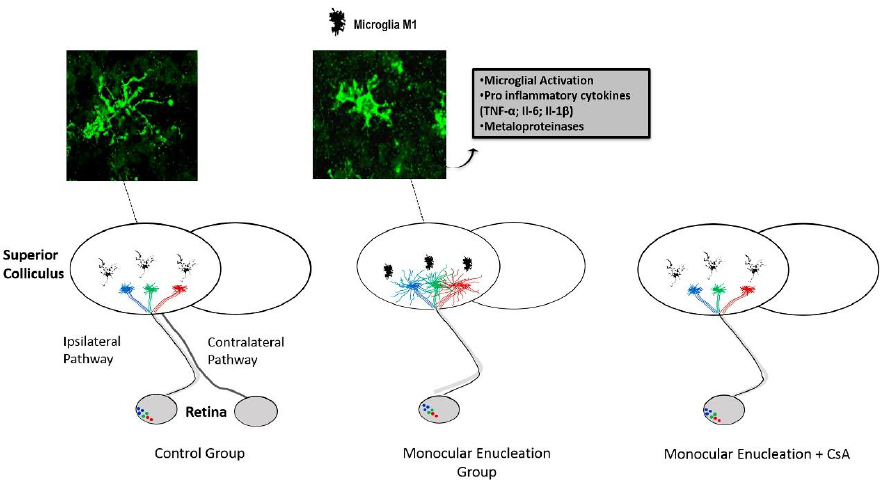
Figure 1. The rodent visual system reveals the effect of microglial activation on the modulation of the regenerative capacity of axons from the intact eye axons following a neonatal lesion (monocular enucleation) during early postnatal development. Under normal conditions, the retinal axons that form the ipsilateral pathway make connections to specific regions of the superior colliculus (SC). Following a monocular enucleation at P10, an extensive contralateral SC denervation occurs, followed by rapid compensatory growth of the axons from the intact eye. This plasticity depends on microglial activation, as it is abolished by immunosuppressive drugs (cyclosporin A or minocycline) administered intraperitoneally. Adapted from [78] with permission from S. Karger AG, Basel.